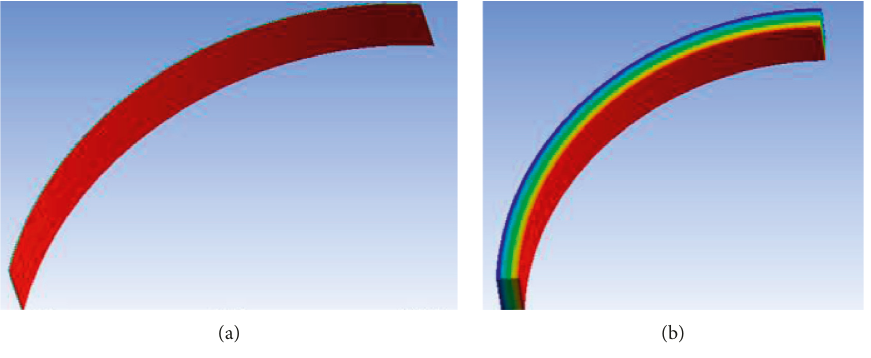
Figure 10: Surface force analysis model.